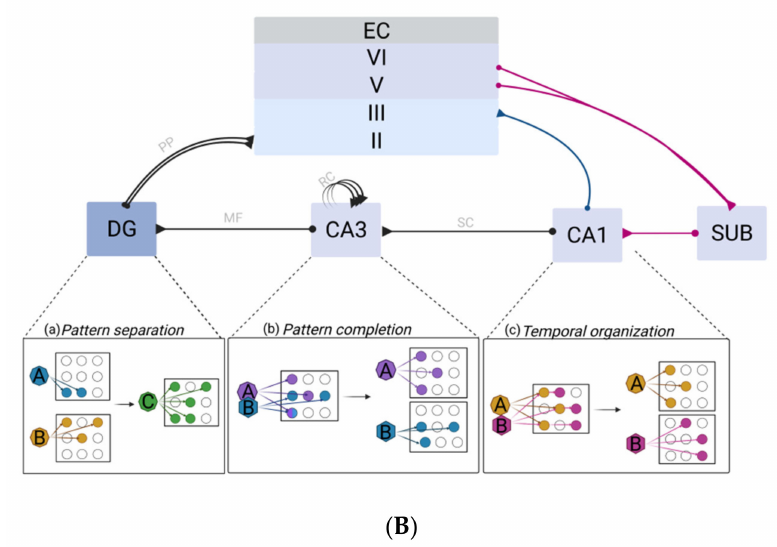
Figure 1. ( A ) Schematic representation of the location of hippocampal formation in both humans and rodents (left). Circuitry organization of the hippocampal formation in both species is depicted (right). Main inputs to the hippocampus are provided by superficial layers of the EC. Inputs converge to the CA1 through both the tri-synaptic pathway (DG, CA3 and CA1) and monosynaptic pathway, directly to the CA1 through the layer II of the EC. Recurrent collaterals (RC) of the CA3 contact other CA3 neurons and form the auto-associative network. The CA1 connection with the subiculum provides the main hippocampal outflow back to the deep layers of the EC (adapted from Small et al. 2011). ( B ). Representation of the functional specialization of each hippocampal subfield. The DG–CA3 axis is assigned to pattern separation (a), a function allowing it to disambiguate sensory inputs from similar experiences. Two similar inputs (A) and (B) are thus represented as two non-overlapping inputs. The pattern-separated signals from the DG are then projected onto the CA3 via the mossy fibers (MF) pathway. The CA3 is specialized in pattern completion (b), a process by which a partial or degraded subset (A) and (B) of the initial input can re-activate the retrieval of the whole context through a generalization process (C). The CA1 performs temporal organization of sequentially activated place cells (c). During spatial navigation, temporally close events (A → B) activate place cells in sequences that are then played out separately on a compressed time scale as a specific theta sequence (A/B). Abbreviations: CA1, CA3: cornus ammonis 1,3; DG: dentate gyrus; EC: entorhinal cortex; lpp, lateral perforant path; MF: mossy fibers; mpp, medial perforant path; PP, perforant path; SC, schaffer collateral pathway; RC: recurrent collaterals; SUB: